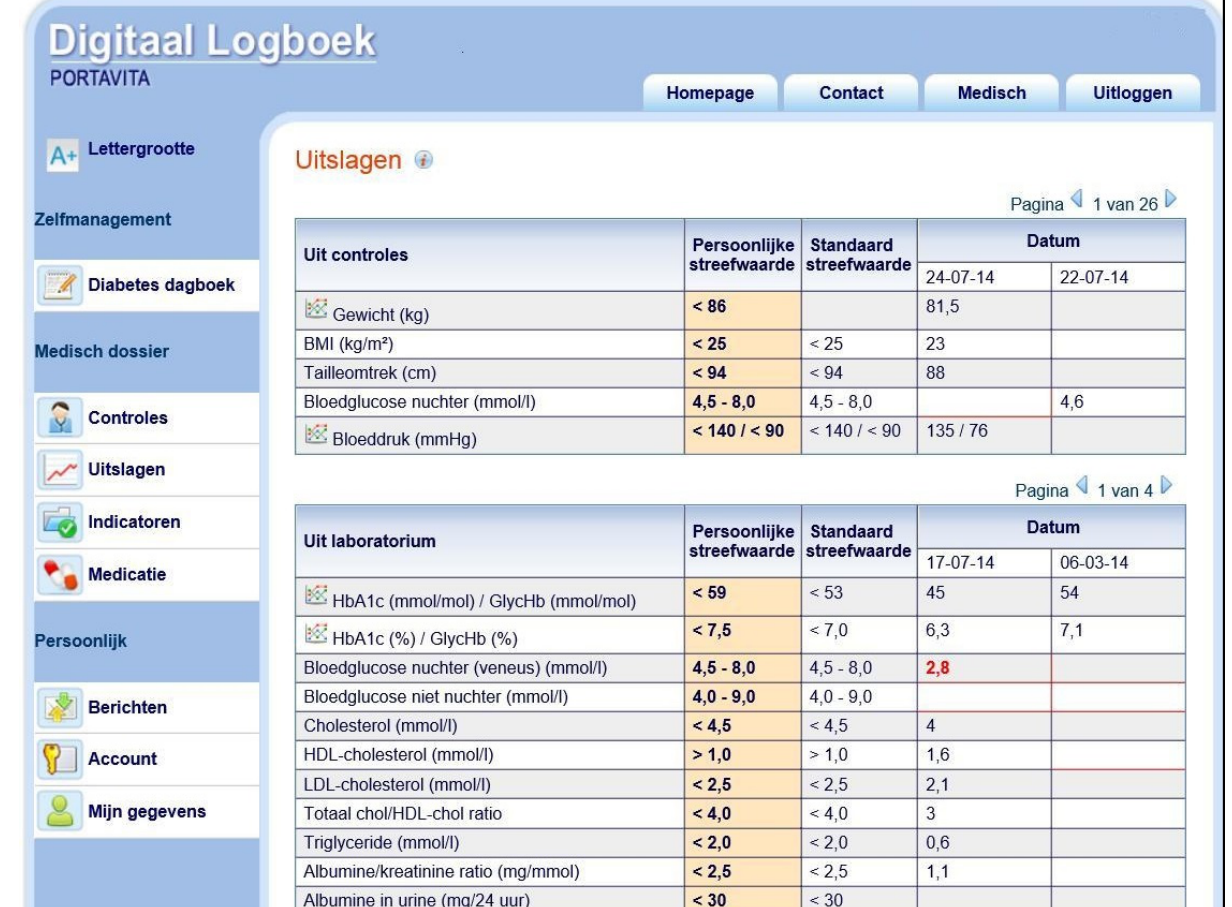
Figure 1. Screenshot of the laboratory results and treatment goals of the patient Web